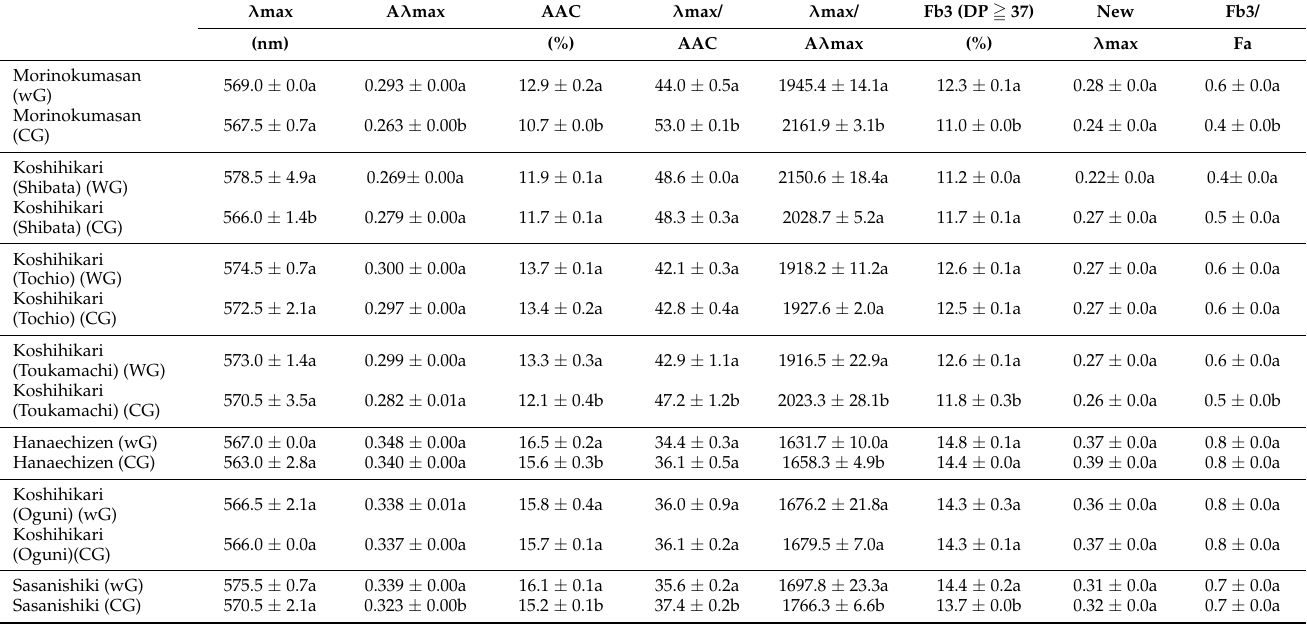
Table 2. Analysis of iodine absorption parameters of whole and chalky rice grains from 7 Japonica rice samples in